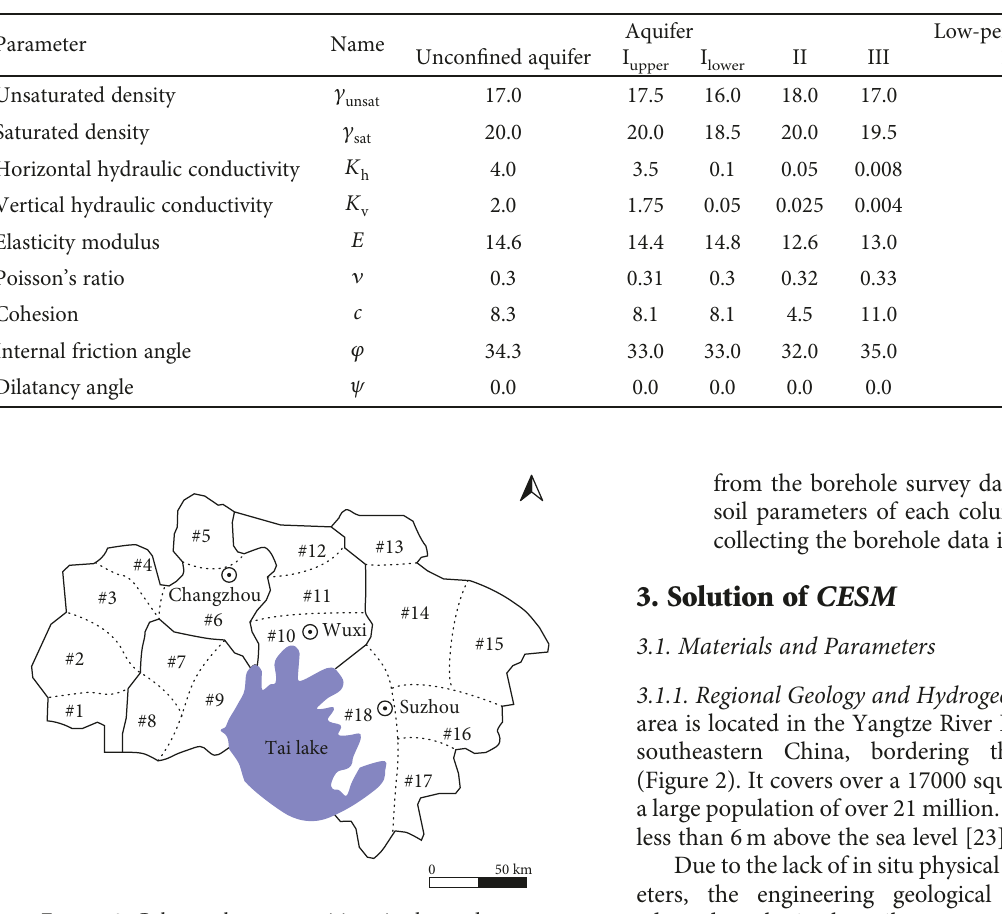
Figure 3: Column element partitions in the study area.